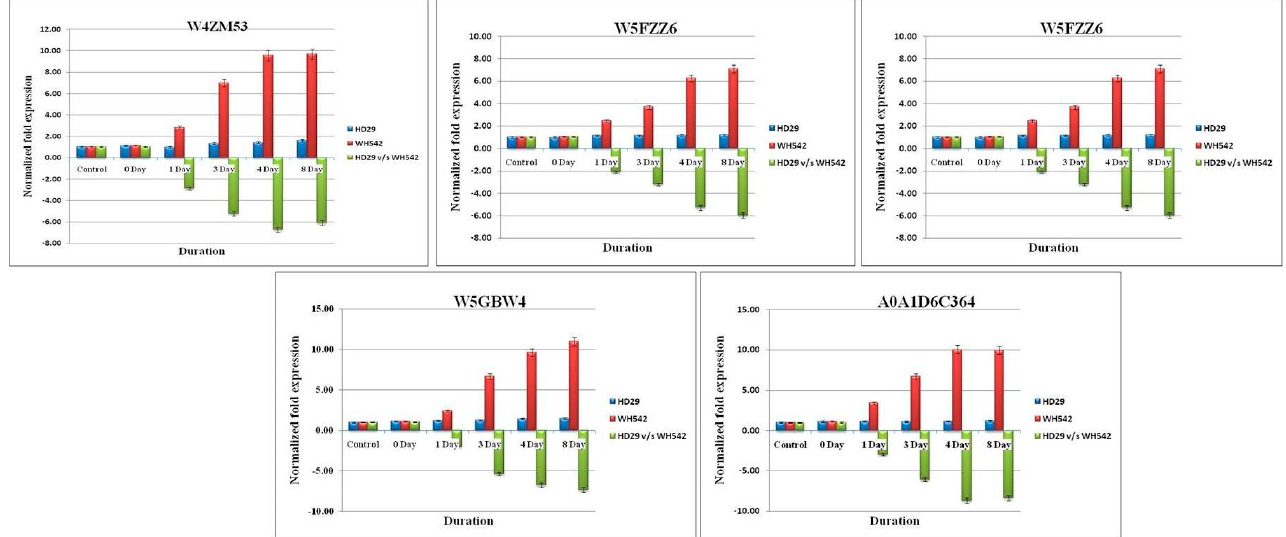
Figure 6. Real-time quantitative PCR (RT-qPCR) validation of RNA sequencing (RNA-Seq) data through randomly selected downregulated DEGs in the wheat infection. Relative fold change values were generated for RT-qPCR samples by comparing the expression of genes at each time point of infected resistant (HD29) vs. susceptible (WH542) wheat varieties. Data are presented as means ± standard error (SE) from three independent